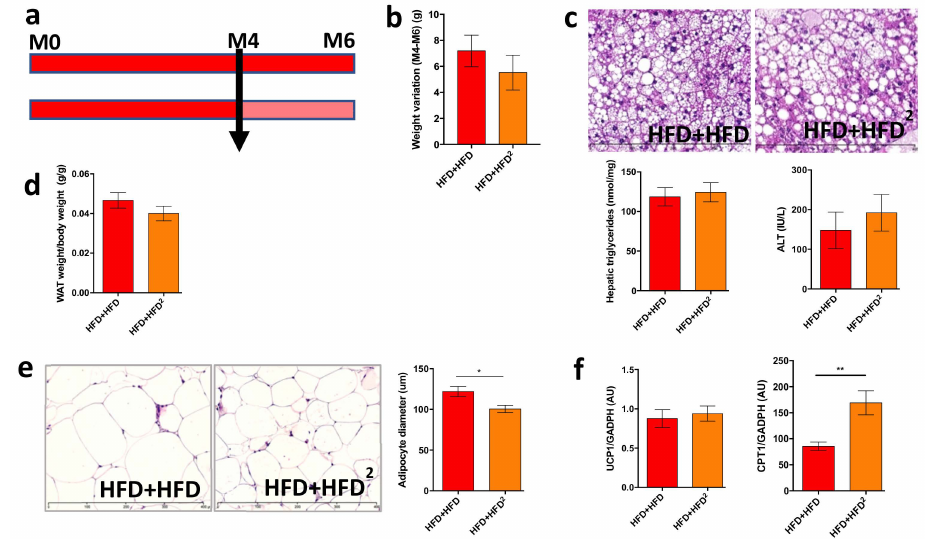
Figure 3. Pectin supplementation in HFD mice induces WAT browning but is not sufficient to improve liver steatosis. Mice were fed an HFD for 16 weeks and received pectin supplementation in the HFD (2%) from week 16 to week 24 as a curative treatment (HFD + HFD 2 ) versus mice who did not receive pectin (HFD + HFD): ( a ) design of the mouse experiment. ( b ) Change in body weight between 16 (M4) and 24 weeks (M6). ( c ) Histological images of a liver tissue section stained with hematoxylin-eosin (scale 400 µ m), hepatic triglyceride content, and plasma ALT. ( d ) White adipose tissue (WAT) weight/body weight ratio. ( e ) WAT section stained with hematoxylin-eosin (scale 400 µ m) and histomorphometric analysis of adipocyte diameter ( µ m). ( f ) Quantification of mRNA expression by RT-qPCR of UCP1 and CPT1 in WAT. Data represent the mean ± SEM of eight mice. * p < 0.05, ** p <